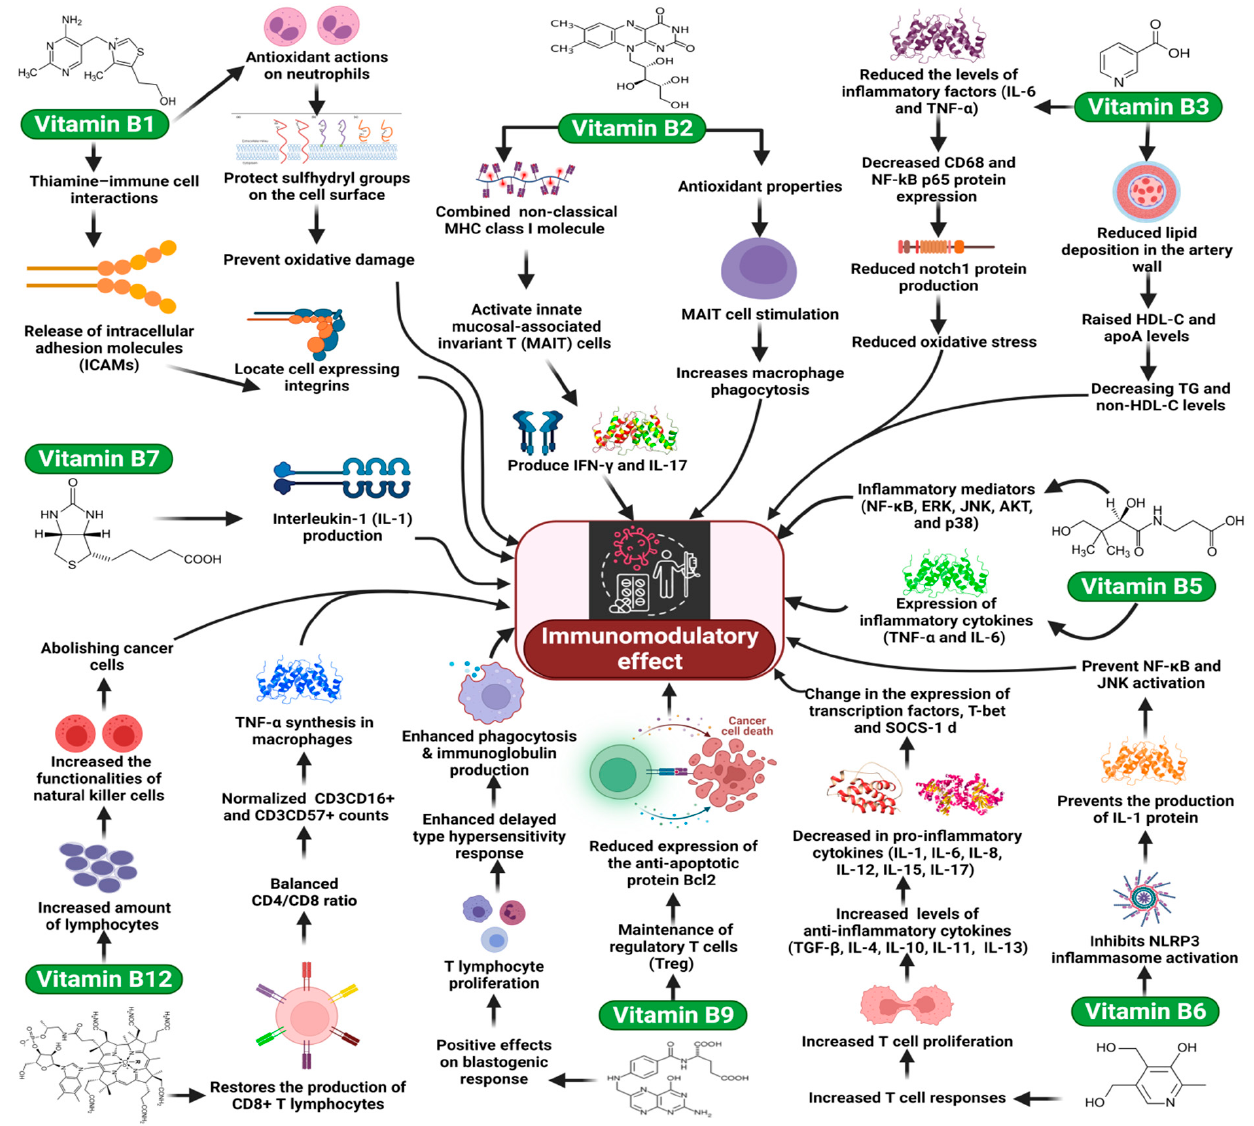
Figure 1. The key role of vitamin B as immunomodulators.